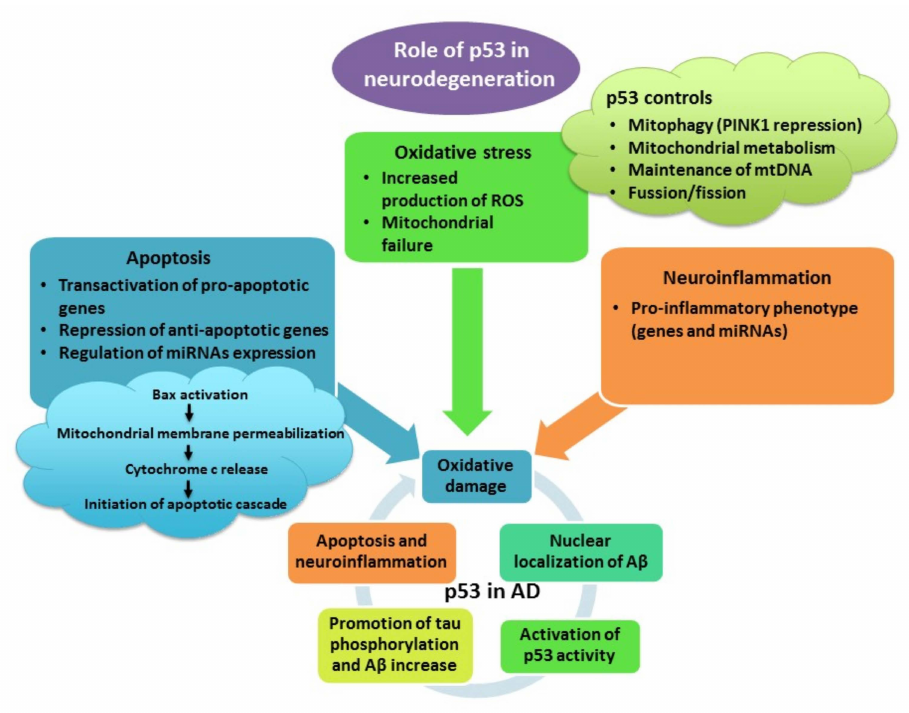
Figure 4. The contribution of p53 to neuronal death, oxidative stress and neuroinflammation. The mutual connections between p53, A β and tau in Alzheimer’s disease are